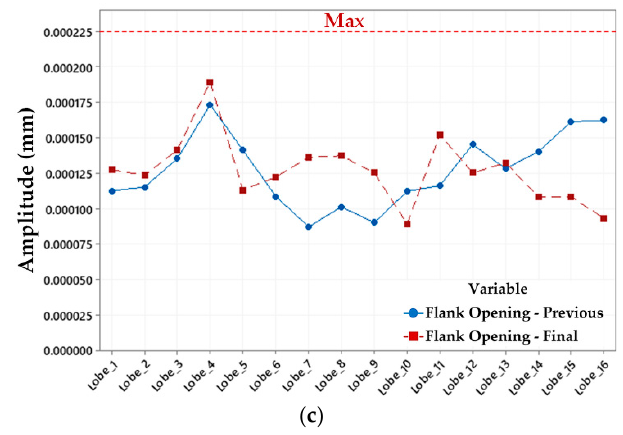
Figure 14. Dimensional measurements of the camshaft lobes before and after the spin rig test for ( a ) flank closing, ( b ) base circle, and ( c ) flank opening.